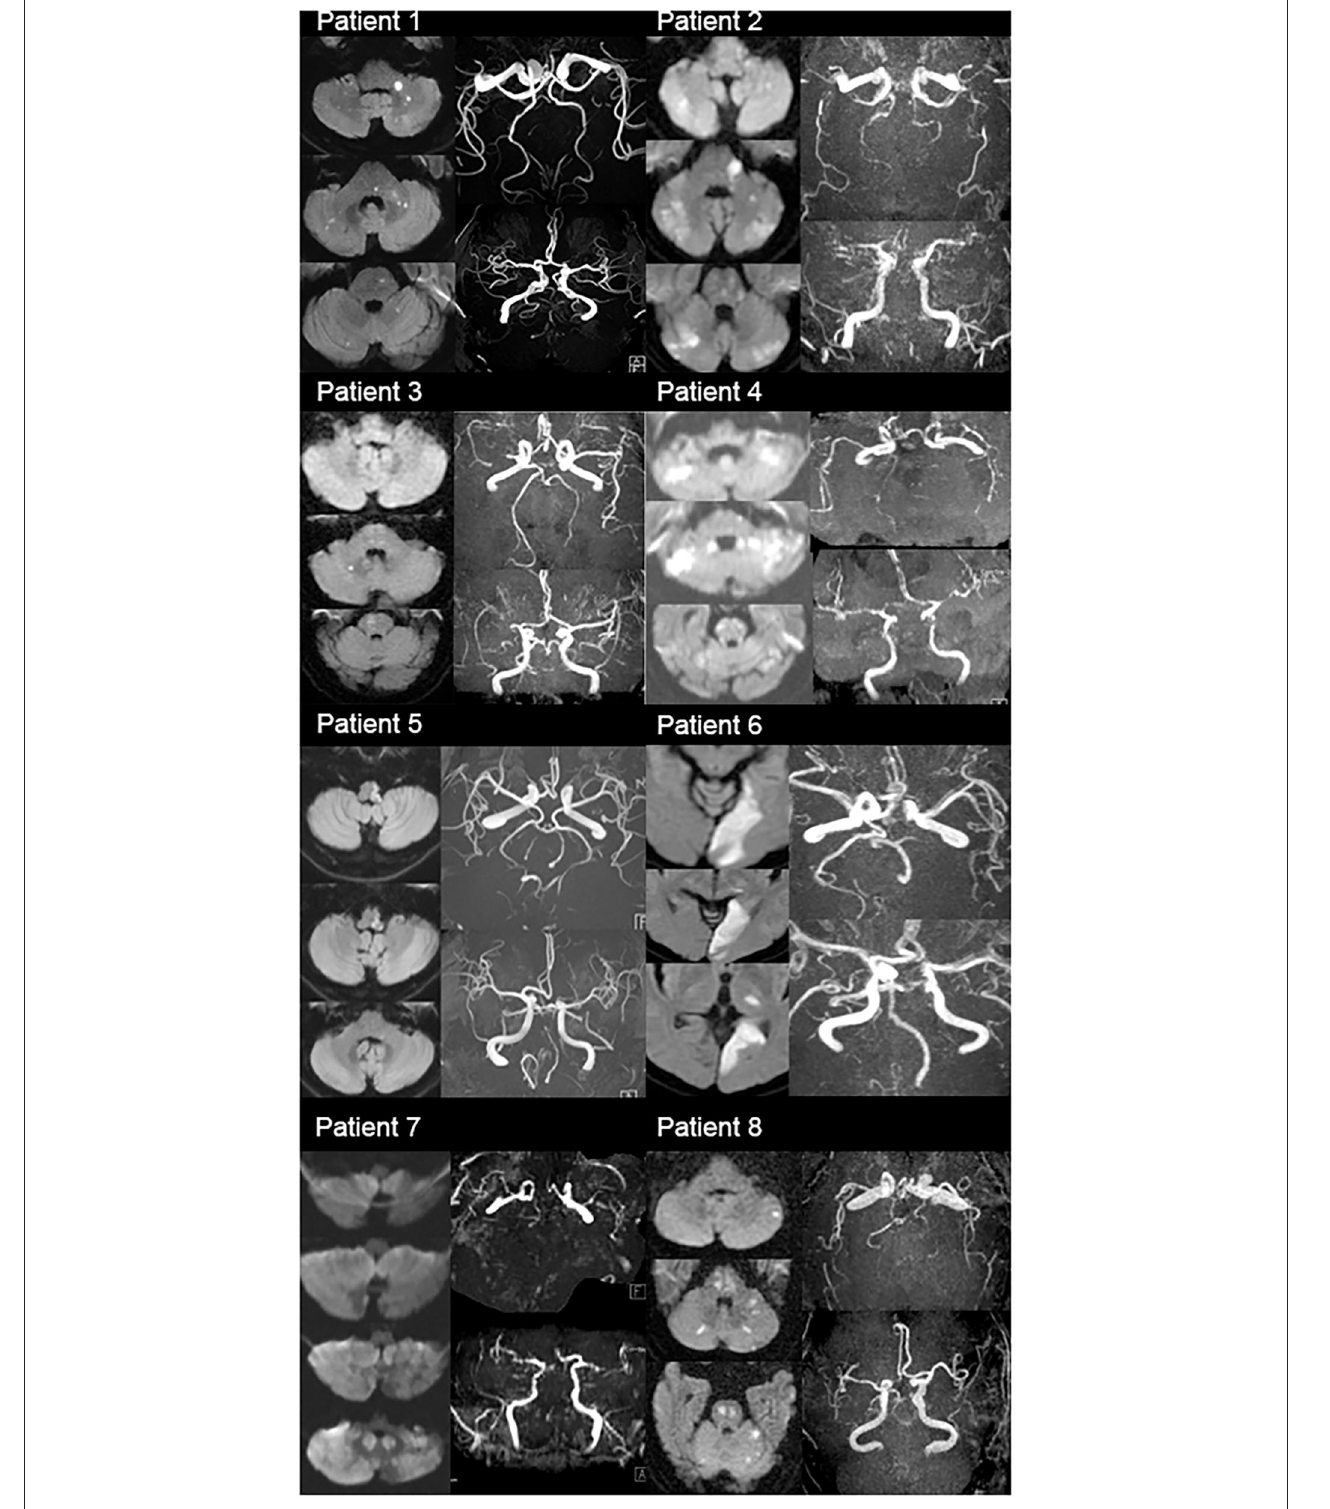
FIGURE 1 | MRI diffusion-weighted images (DMI) and MRA images of total eight patients (MRI DWI showed multiple infarctions in these patients; MRA showed fetal type PCA, vertebral hypoplasia, small caliber of basilar artery, or invisible vertebrobasilar arteries).